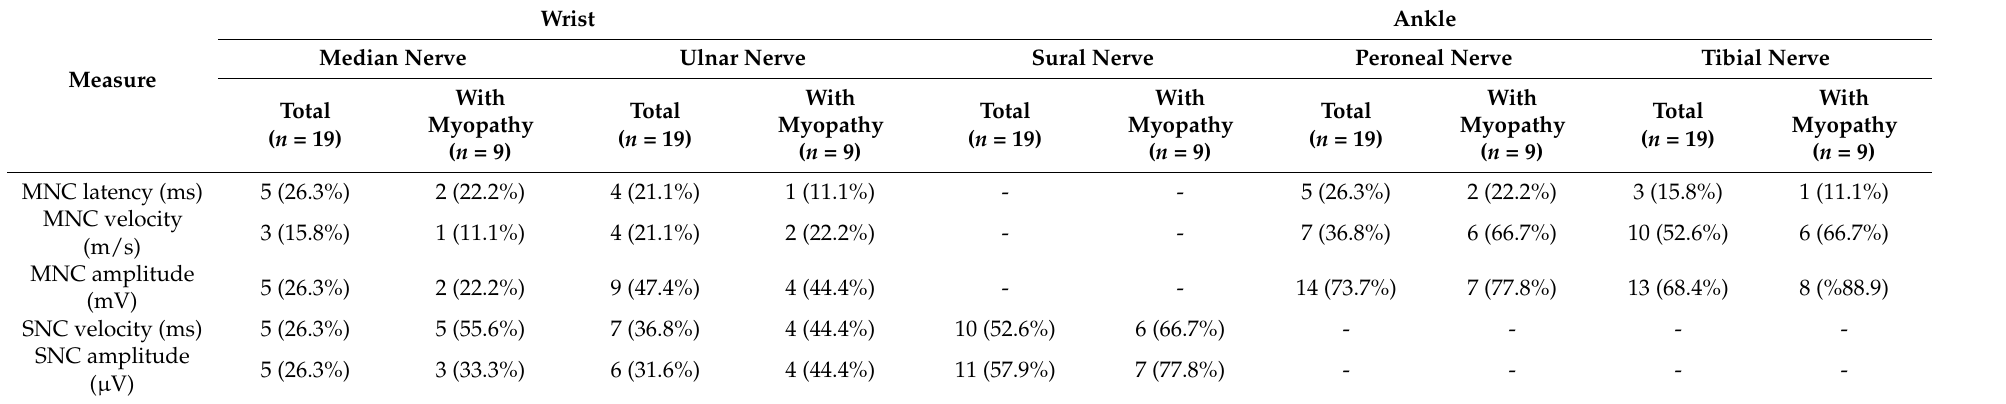
Table 1. Number of subjects (percentage of total n = 19 in parentheses) and number of subjects with myopathy (percentage of n = 9 in parentheses) with